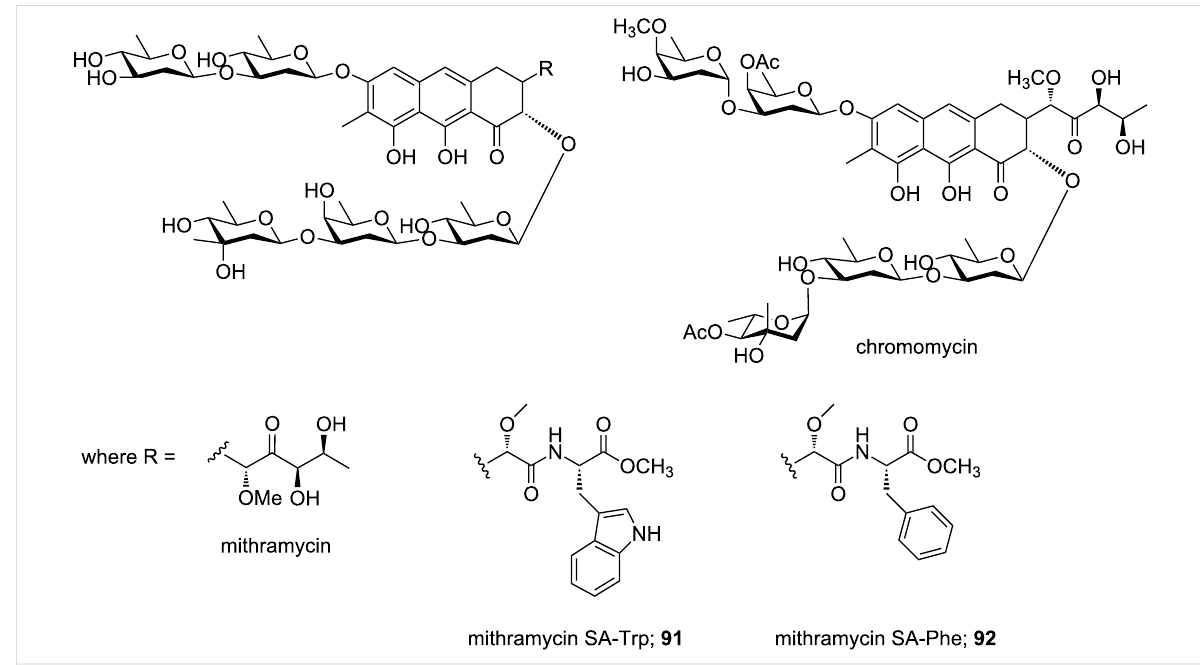
Figure 13: Chemical structures of chromomycin, mithramycin and their synthetic structural analogs 91 and 92 .